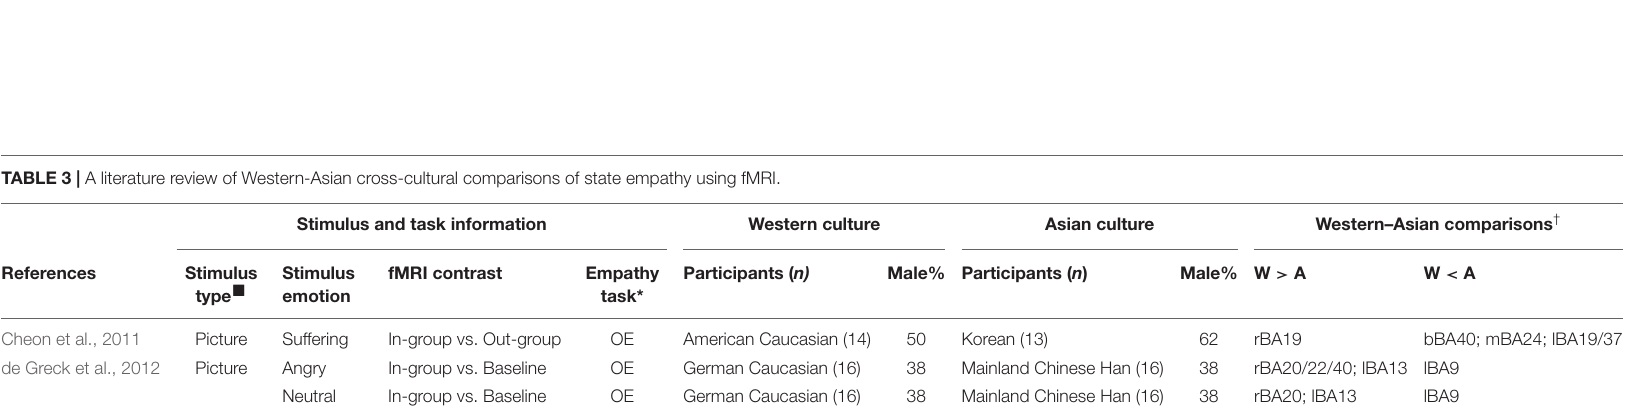
(cid:4) For the stimulus type, Cheon et al. (2011) presented emotional pictures with a relevant emotional background (e.g., a natural disaster or a social activity), while de Greck et al. (2012) presented photos of facial expressions with a plain back-drop. *For the empathy task, OE, the overall empathy (i.e., the integrated concept of emotional and cognitive empathy). † For the Western–Asian comparisons, W, Western participants; A, Asian participants; b/l/m/rBA, the bilateral, left, middle, and right side/s of a Brodmann Area,